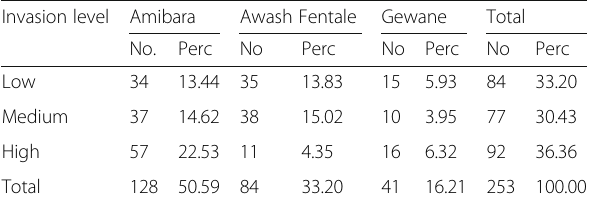
Table 3 Prosopis invasion levels of sample households